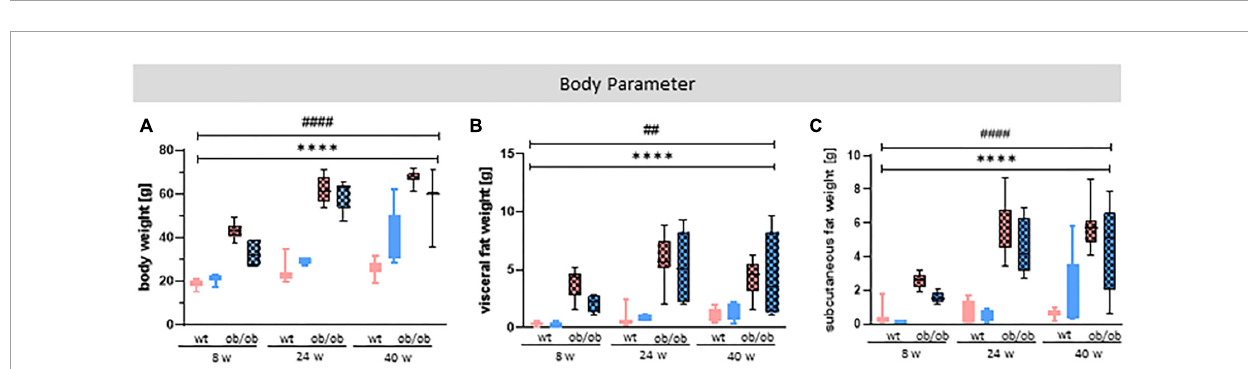
FIGURE1 Experimental design. Graphical illustration of the experimental procedure; Male ( at the age of 8, 24, and 40 weeks were firstly habituated to the testing room on day 1 for 24 h; behavioral tests were conducted on day 2 [Elevated Plus Maze (EPM)] and 3 [Open Field (OF)]. After behavioral tests were conducted the animals were killed to obtain physiological data. All behavioral data were analyzed with both EthoVision (EV) and DeepLabCut (DLC), and statistically evaluated with GraphPad Prism and Excel. The graphic was created with BioRender.com.